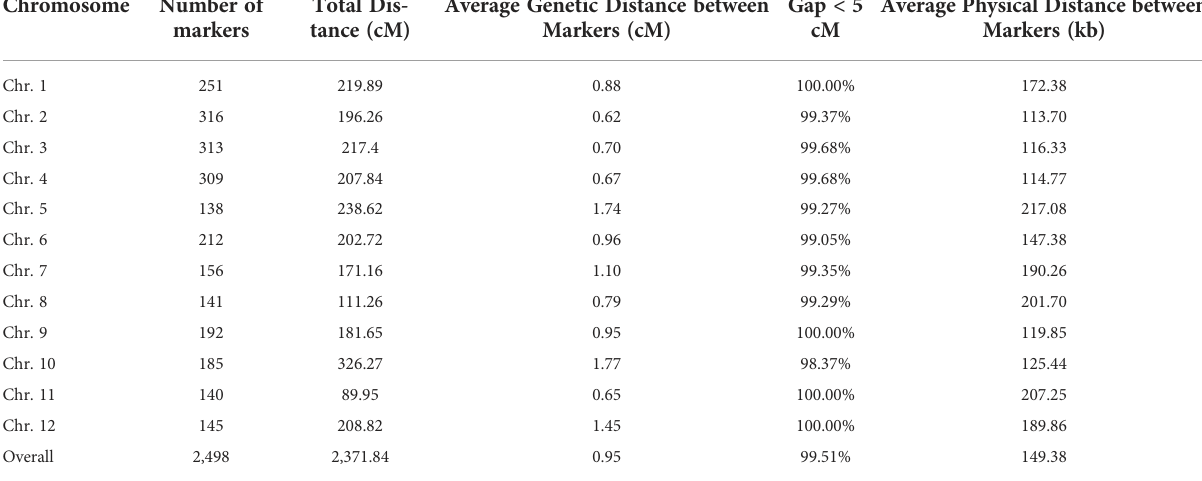
TABLE 1 Distribution of genetic markers across the 12 chromosomes in rice. Chromosome Number of